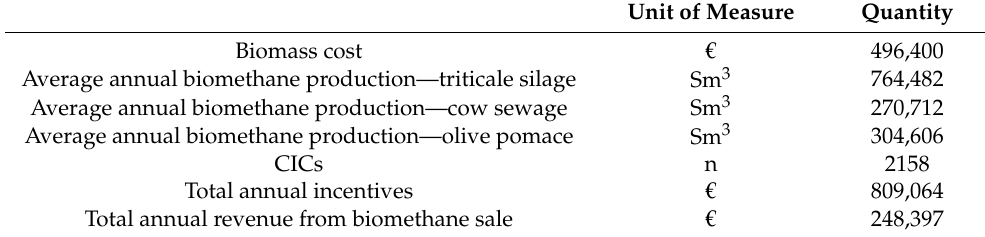
Table 4. Results of Example